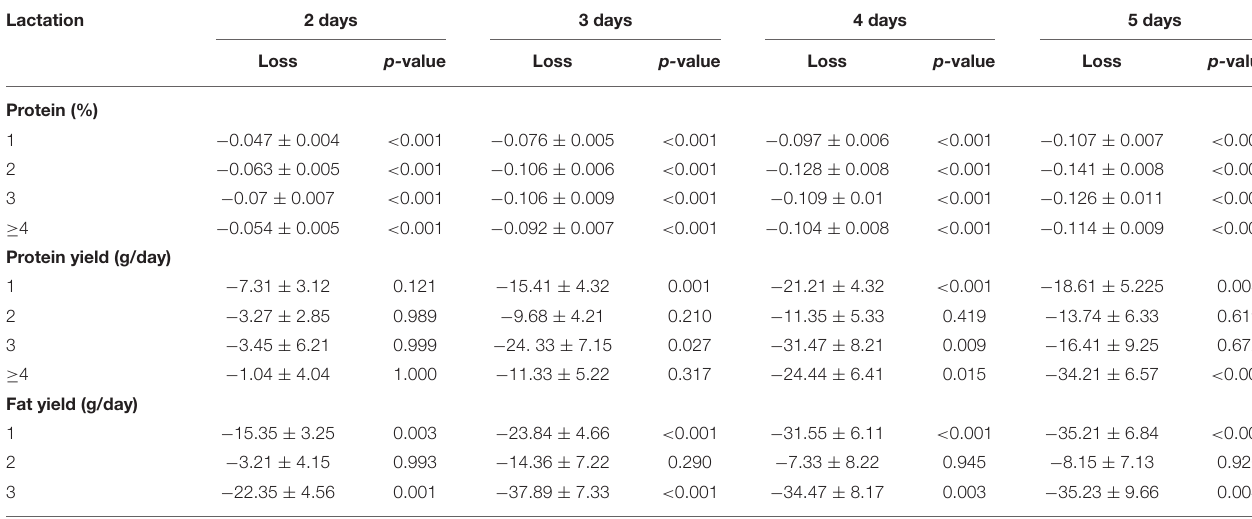
TABLE 4 | Relative variation of protein concentration (%), protein yield (g/day), and fat yield (g/day), after heat waves lasting 2, 3, 4, and 5 consecutive days, in comparison with the losses estimated after a single day of daily maximum THI over the threshold, for the different parity classes. Lactation 2 days